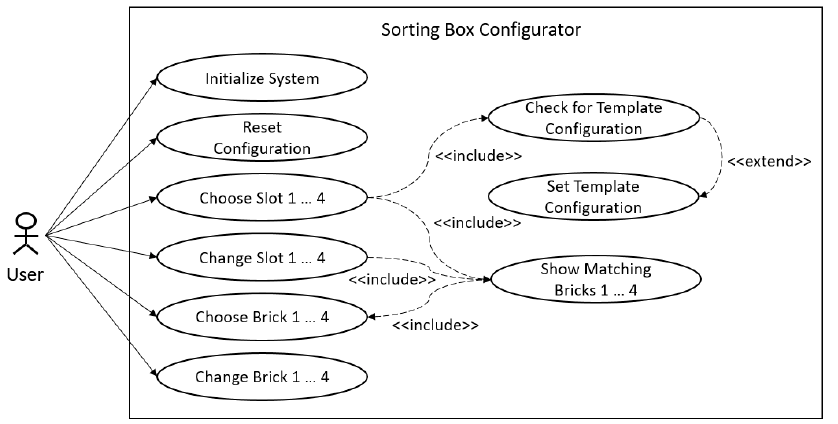
Figure 3. Use case diagram for customer interaction.